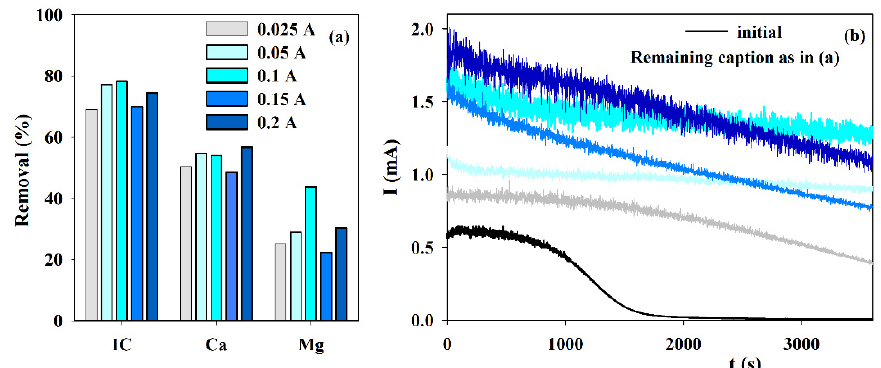
Figure 3. Influence of the current intensity on the ( a ) IC, Ca 2+ and Mg 2+ removals, during electrolysis (I = 0.025 to 0.2 A; Anode—BDD 20 cm 2 ; Cathode—SS 20 cm 2 ; Stirring speed—1000 rpm; 4 h), and ( b ) chronoamperometric tests (E = − 0.96 V vs. Ag/AgCl) with S solution before and after the electrolytic assays at different intensities.